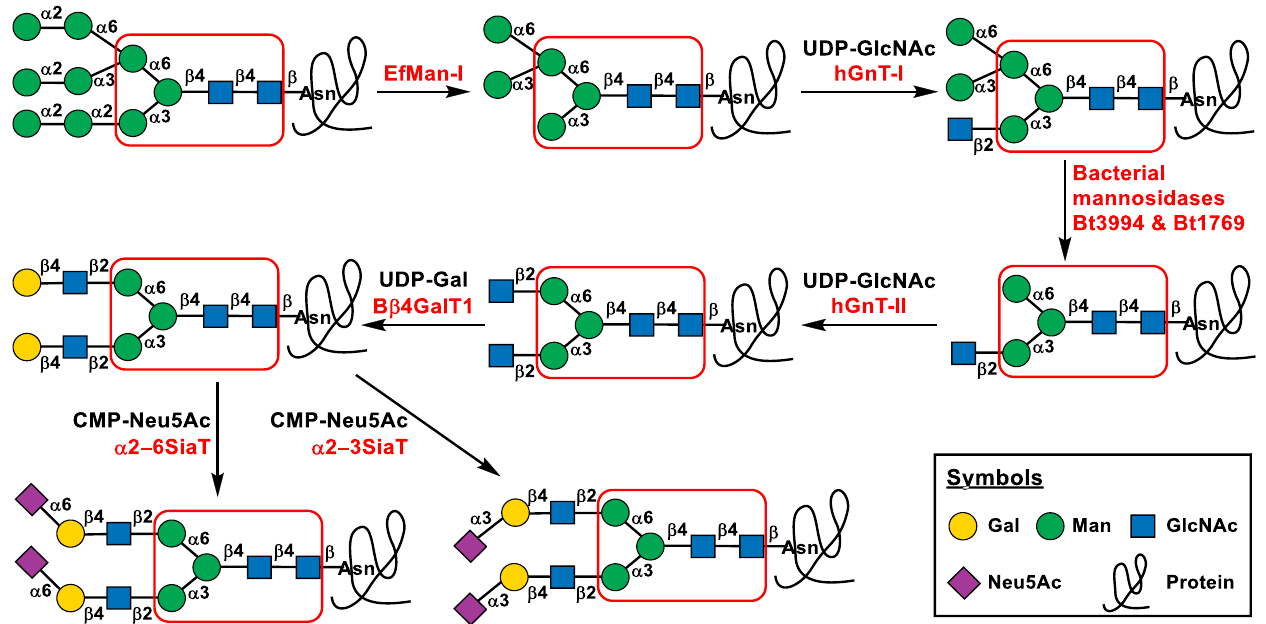
Figure 1. Glycoprotein in vitro N-glycan processing from high-mannose to disialylated biantennary complex-type N-glycans. The conserved trimannosyl chitobiose core (Man 3 GlcNAc 2 ) of eukaryotic glycoprotein N-glycans is highlighted in a red rectangle.